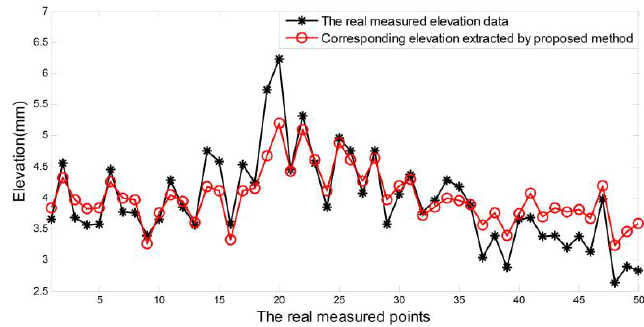
Figure 15. Real measured elevation data and the corresponding marking elevation extracted from the decomposed sparse components.